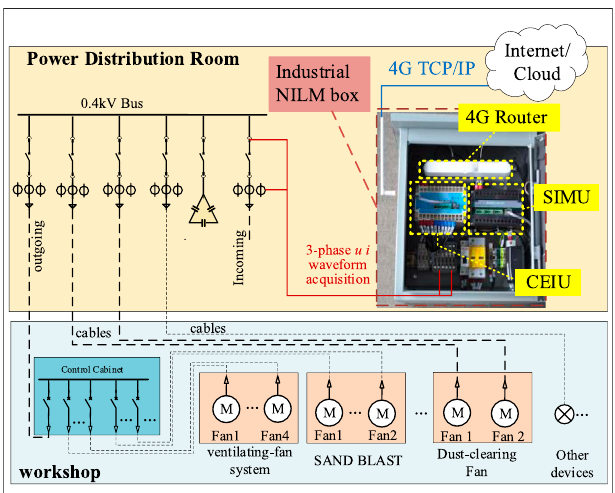
FIGURE 8 | Low-voltage power distribution system and equipment in a workshop.